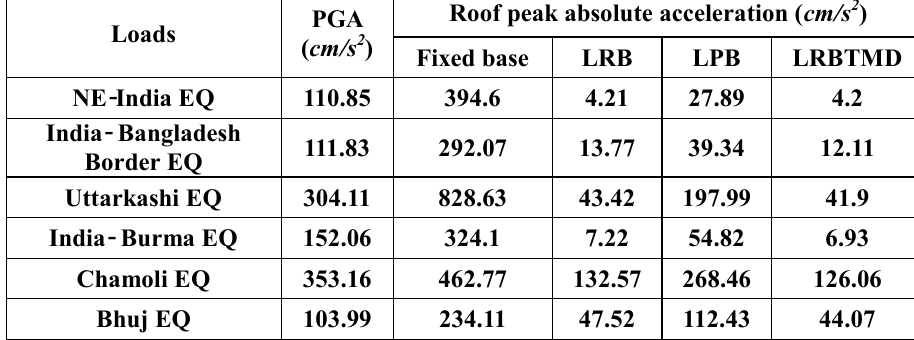
Table 5 Roof peak absolute acceleration under earthquakes.